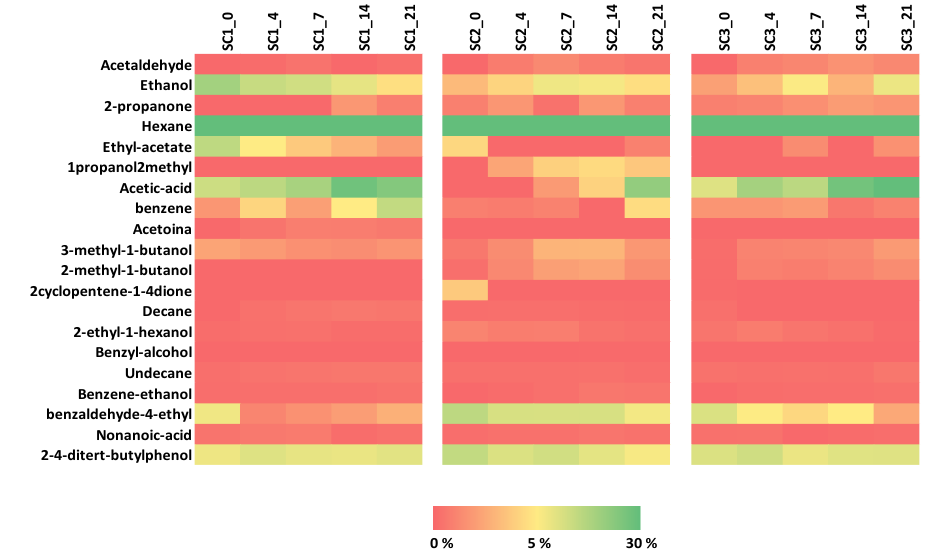
Figure 6. Heatmap of volatile profile of ST kombucha fermented using SCOBYs 1, 2, and 3 (SC1, SC2, SC3). Colors range from red (0%), to yellow (5%), and to green (30%), showing the relative percentage of the total VOCs detected. Numbers 0, 4, 7, 14, 21 refer to the storage period in days.